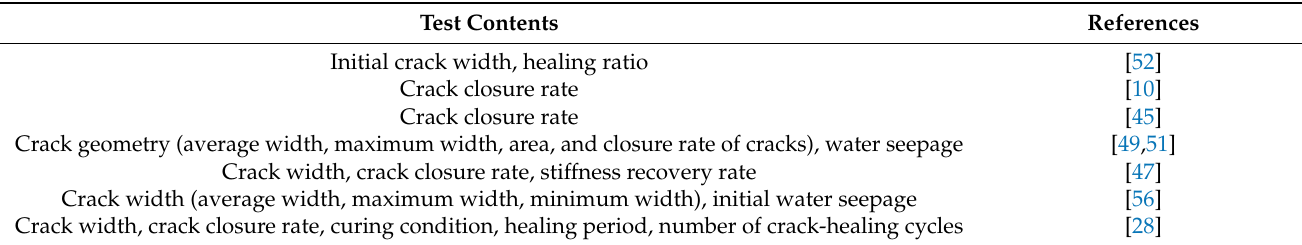
Table 6. Large discreteness of test results.